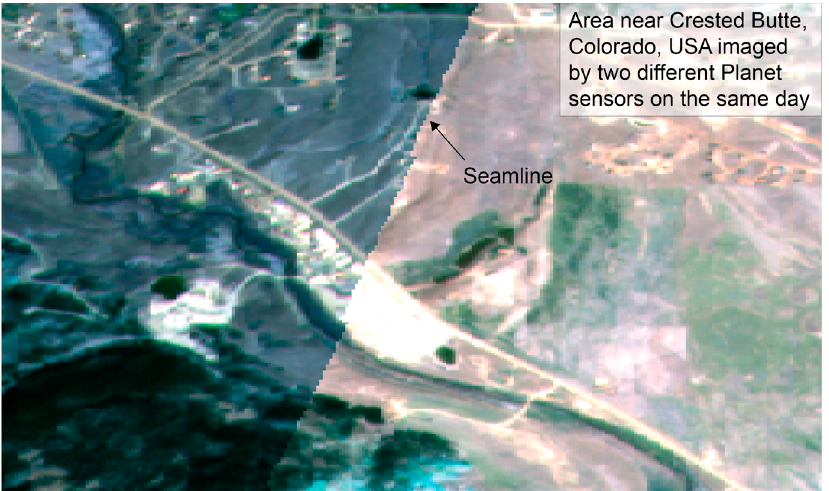
Figure 2. Example of sensor spectral differences in PlanetScope sensors that impact potential repli- cability of studies.